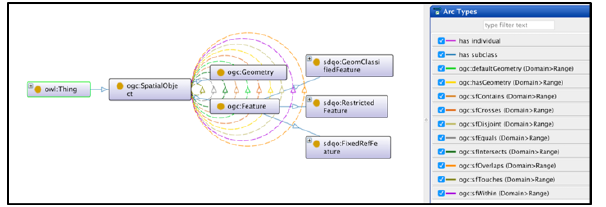
Figure 4. ogc-Feature Class with subclasses. Figure 5. These are sdqo:InterObjectPrRF, sdqo:IntraDataPrRF, sdqo:IntraObjectPrRF and sdqo:InterDataPrRF. Rules and given subclass relations determine which features these classes have. The labels and the descriptions are listed in Table. “Intra” classes are for restrictions within a single class and “Inter” classes are for restrictions in class pairs. sdqo:RestrictedFeature has the label “Features according to the property restrictions”.